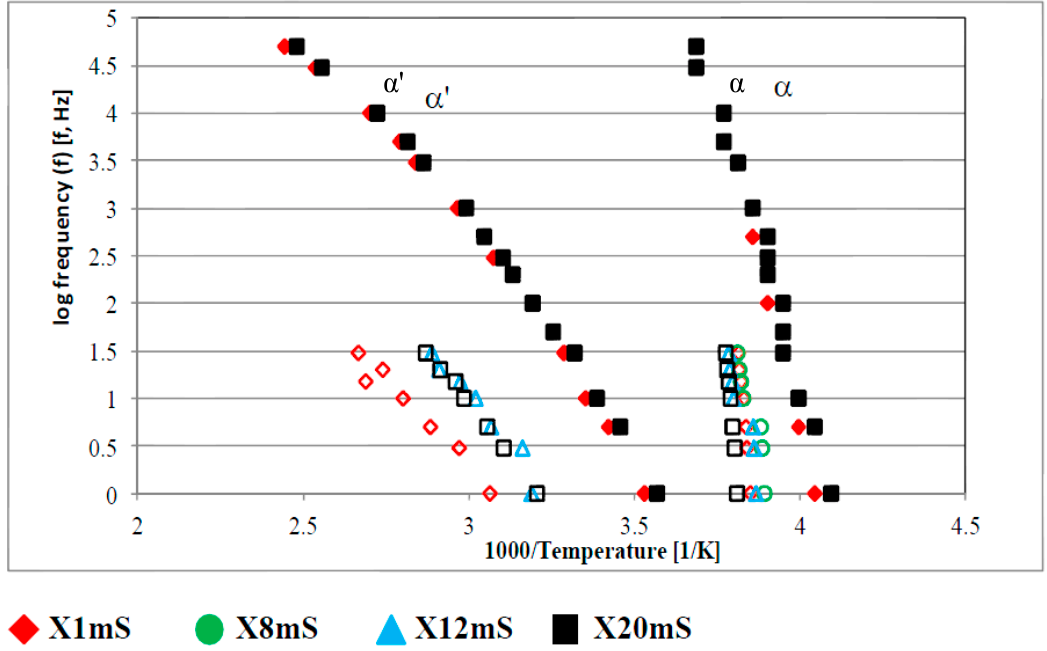
Figure 8. Activation diagrams of XNBR vulcanizates containing silica modified with different amount of zinc oxide (ZnO/SiO 2 ) (full points—DRS and open points—DMA).